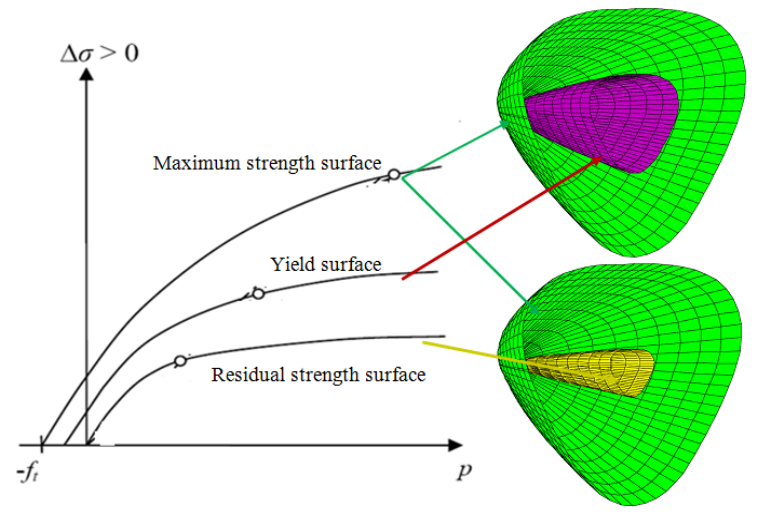
Figure 1. Strength surfaces for the Karagozian and Case concrete model (KCC) material model [14].